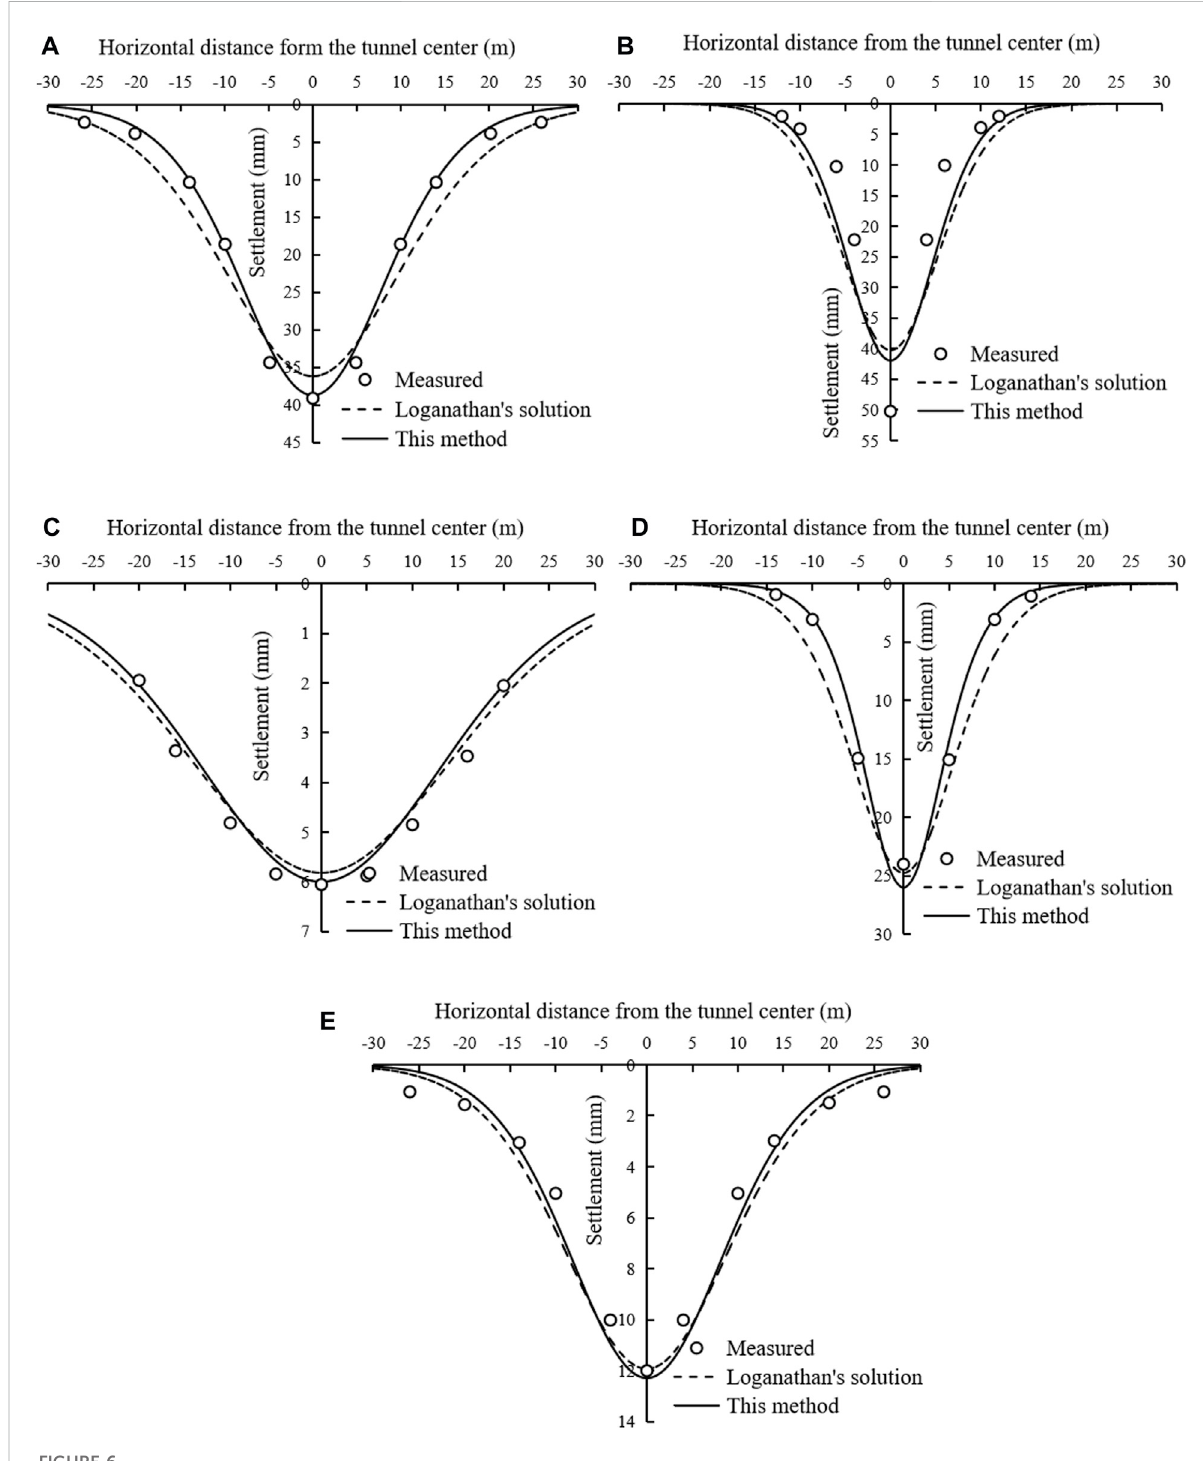
FIGURE 6 Surfacesettlementinducedbygeneralcirculartunneling: (A) HeathrowExpressTrailTunnel; (B) ThunderBayTunnel; (C) GreenParkTunnel; (D) Barcelona Subway Tunnel; (E) Sewer Tunnel,